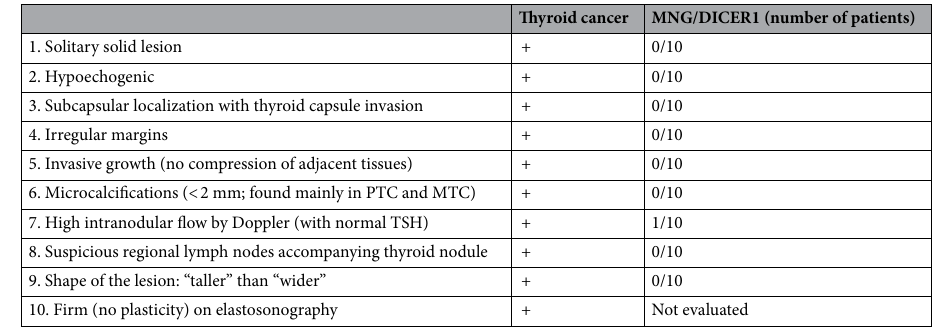
Table 2. Ultrasonographic features of thyroid malignancy and their presence in MNG in patients with DICER1 syndrome (n = 10; 7 < 18 years and 3 ≥ 18 years). PTC papillary thyroid carcinoma, MTC medullary thyroid carcinoma.